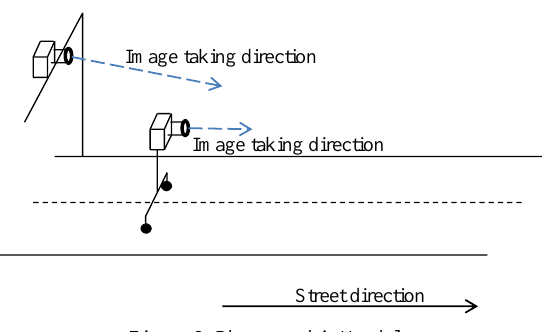
Figure 2. Photographic Model